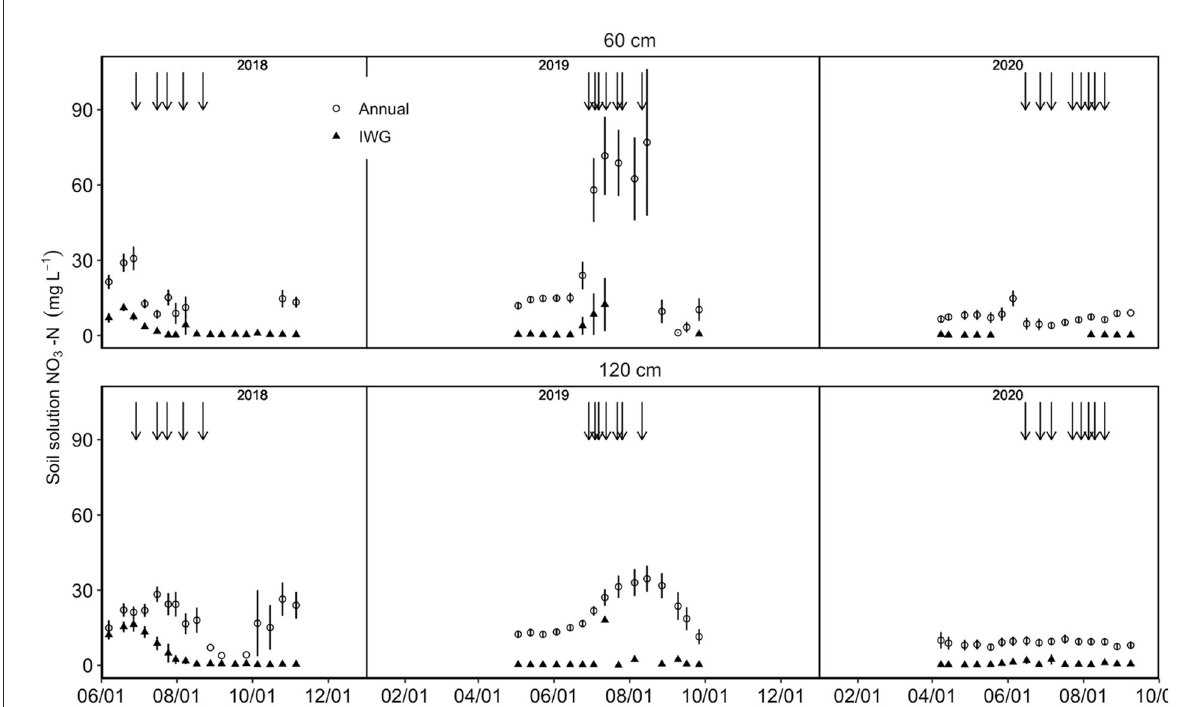
FIGURE1 Mean soil solution NO − 3 -N from lysimeters 60 and 120cm below annual crops (soybean in 2018 and 2020, corn in 2019) and intermediate wheatgrass (IWG) sampled during the growing season in 2018, 2019, and 2020. Points are means from two lysimeters per treatment replicate and six replicates ( n = 12), while error bars indicate standard error of the mean. Arrows indicate dates of irrigation